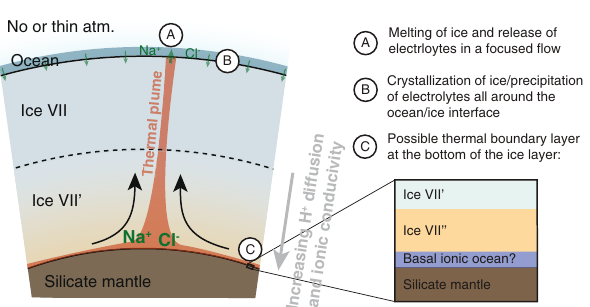
Fig. 5 Transport of salt through the high-pressure ice mantle of a hypothetical water-rich exoplanet with 1 M ⊕ , 50 wt% H 2 O, and a surface temperature of 300 K (corresponds to case 1 in Fig. 3). A thermal plume creates a focused upward fl ux of salty ice that melts at the boundary with the ocean. The crystallization at the bottom of the ocean over a broad area produces a diffuse return fl ow of salt in the mantle. Depending on the initial conditions and on the partitioning coef fi cients of NaCl between the ice and the ocean, the icy mantle may acts either as a well or a source of electrolytes for the ocean. Label C illustrates a possible thermal boundary layer at the bottom of the icy mantle at the contact with the hotter rocky